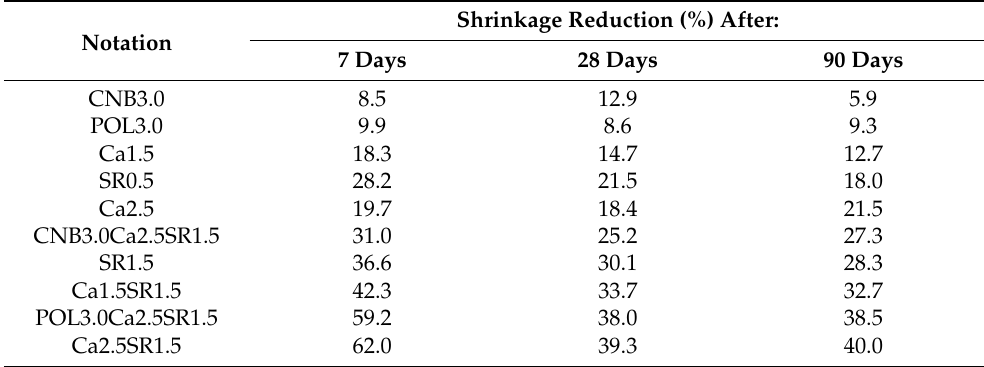
Figure 9. Free ‐ drying shrinkage after 90 days of concrete hardening. Figure 9. Free-drying shrinkage after 90 days of concrete hardening. The percentages of shrinkage reduction, when compared to reference specimen results, after 7, 28, and 90 days are given in Table 5. Table 5. The shrinkage reduction of concrete specimens after 7, 28, and 90